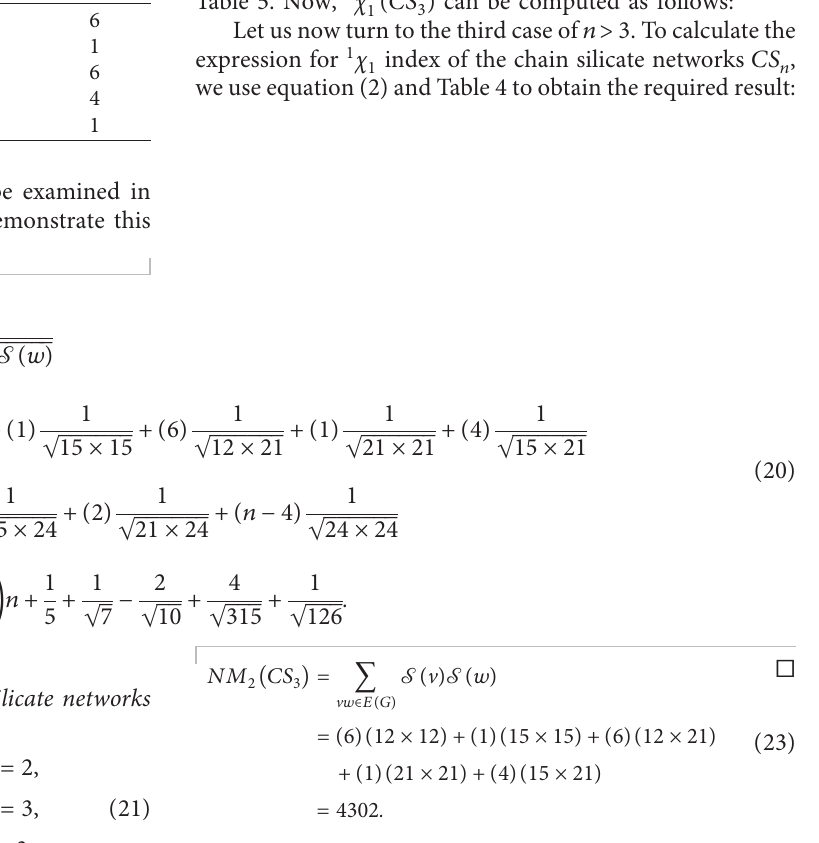
Table 5. Now, 1 χ